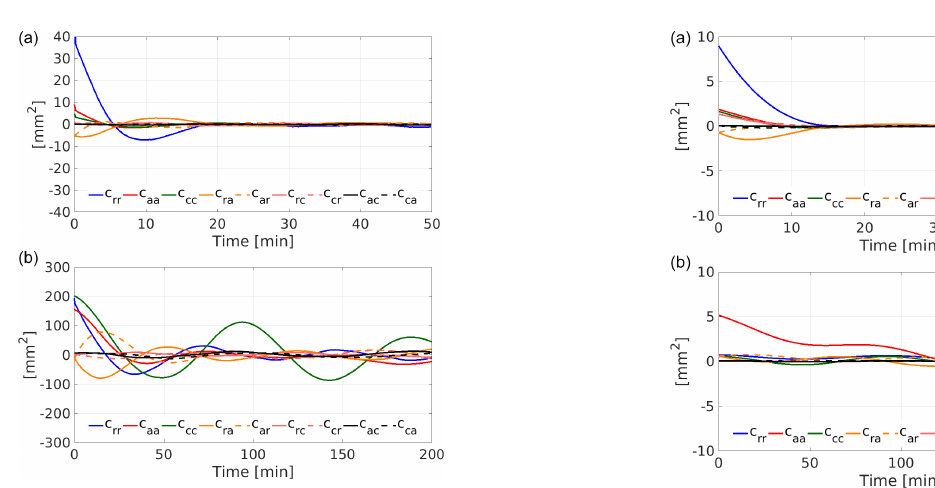
Figure 8. First minutes of the correctional term for the reduced- dynamic orbit parametrisation (a) and the dynamic orbit parametri- sation (b) of day 091, 2007, in